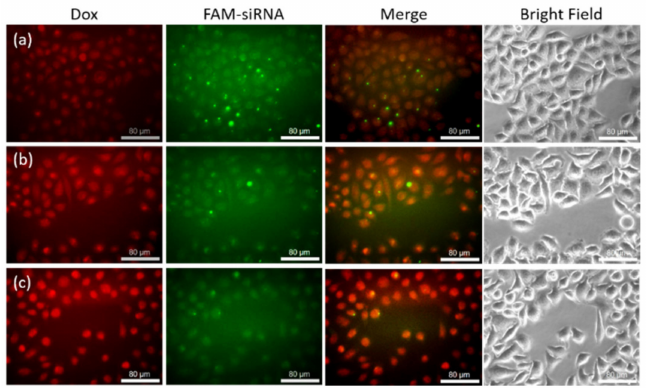
Figure 7. Cellular uptake behavior of Dox/FAM-siRNA chimeric NPs in HeLa cells after incubation for ( a ) 2, ( b ) 4, and ( c ) 8 h. Fluorescence images of cultures showing Dox (red), FAM-siRNA (green), merged images, and bright field images.